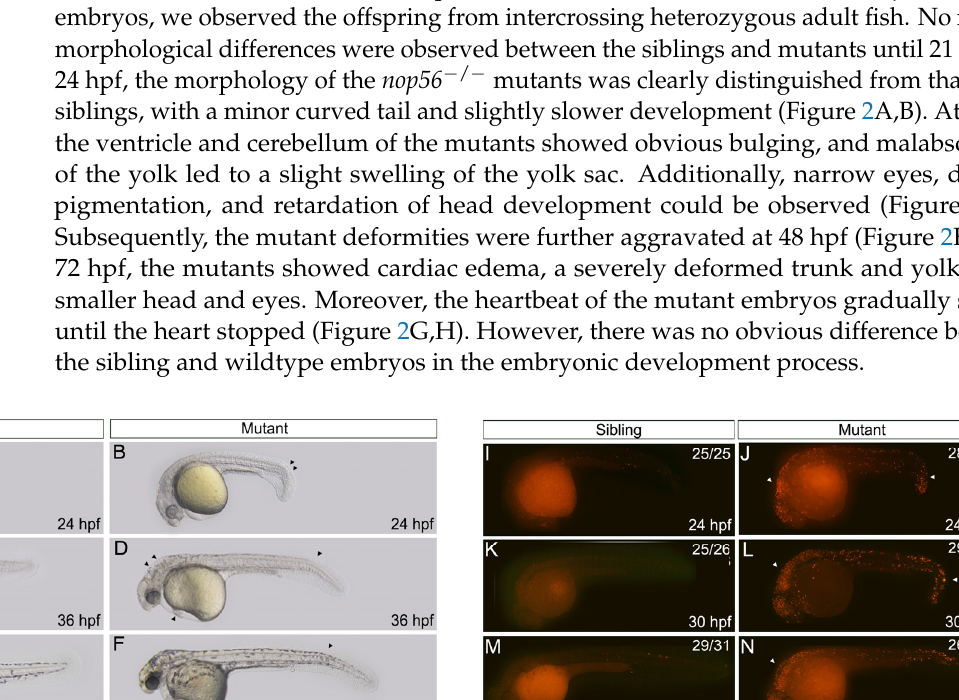
6 of 14 blood cells in the Tg(LCR:EGFP) transgenic line. The arrowhead indicates red blood cells. All scale bars represent 1 mm. After intercrossing these nop56 ( ∆ -5bp) heterozygotes, morphological abnormalities were seen in the presumptive homozygous mutant embryos compared to the siblings, as indicated by pericardial edema, smaller eyes and head, and a shortened and curved body